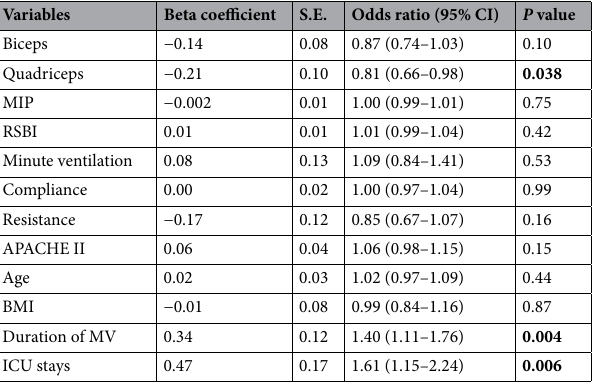
Table 3. Univariate logistic regression analysis of factors associated with extubation failure within the first 3 days following planned extubation. Bold values are statistically significant.